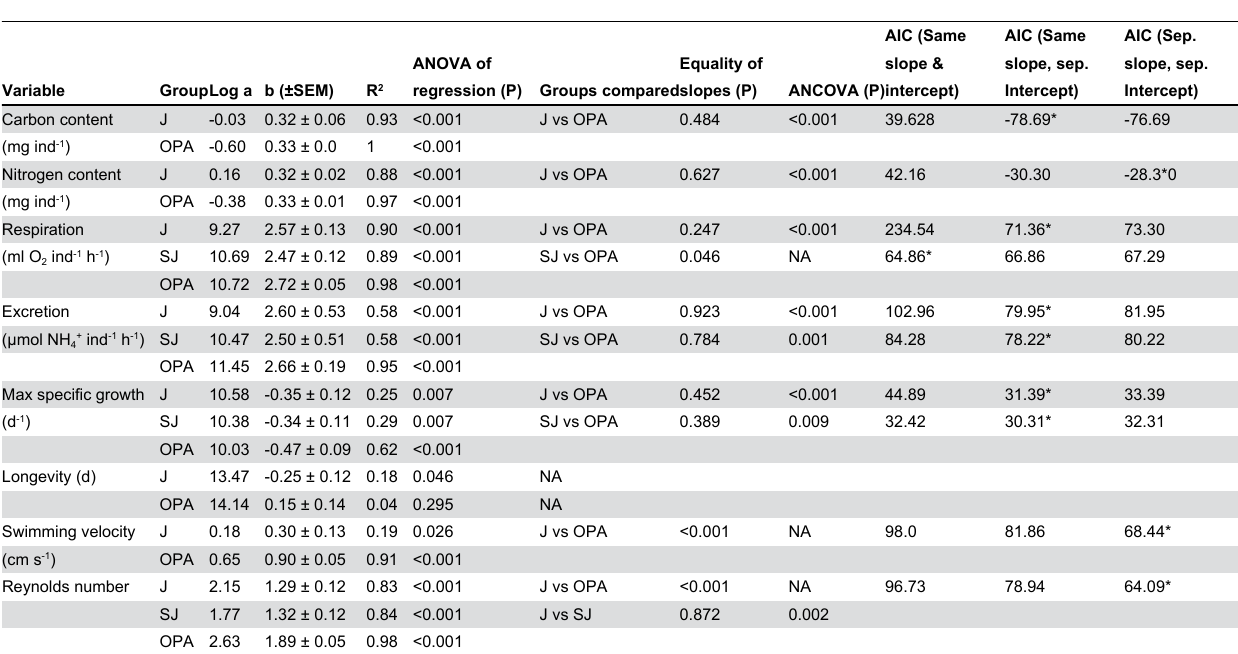
Table 1. Summary of analyses of variance of regressions for jellyfish (J; raw data), jellyfish standardised for carbon content (SJ), and other pelagic animals